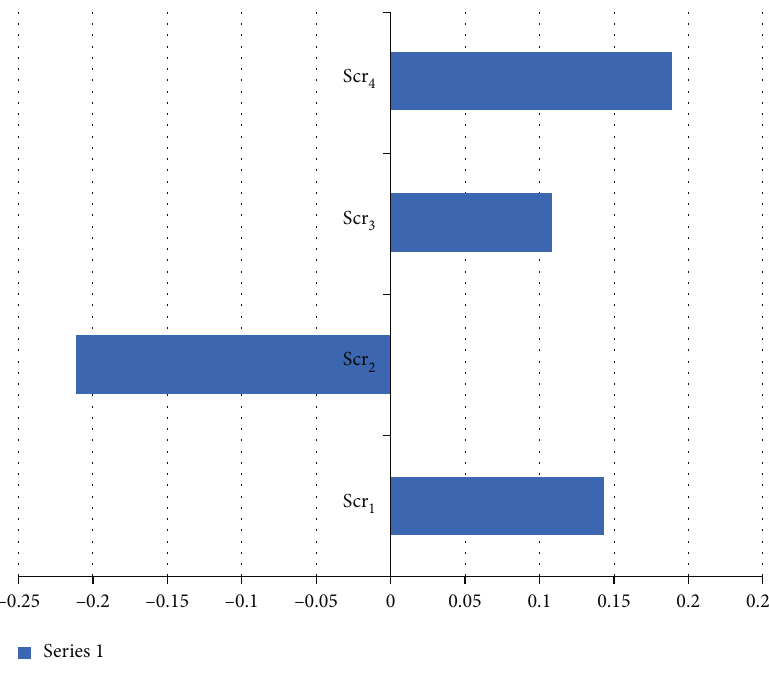
Figure 1: Graphical approach of score